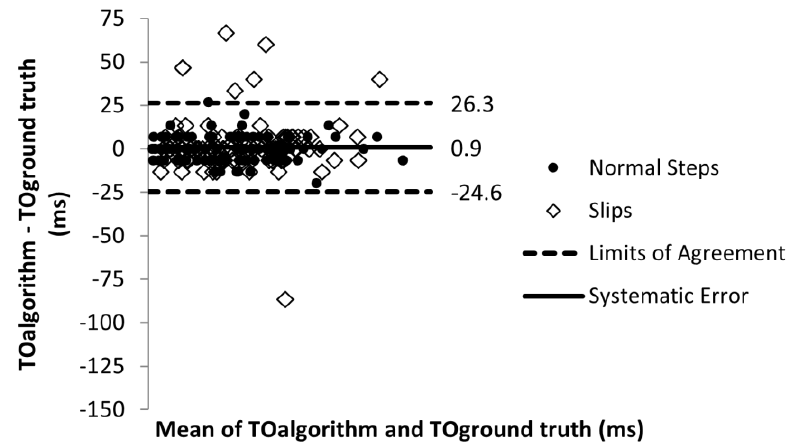
Figure 10. Toe off timing detection error.